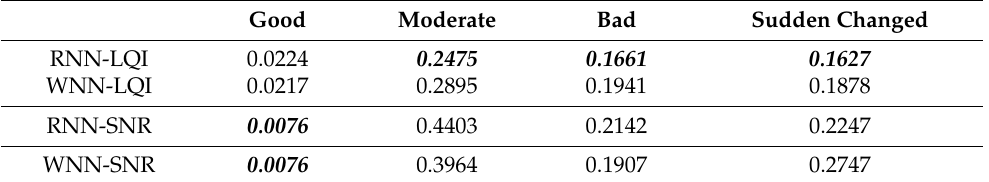
Table 2. RMSEs of PRR prediction under different link qualities.